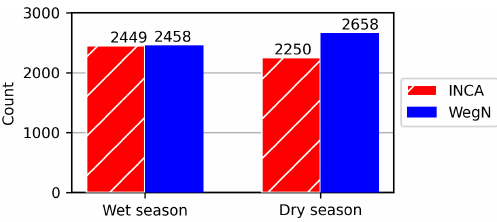
Figure 9. Number of events in different seasons in both